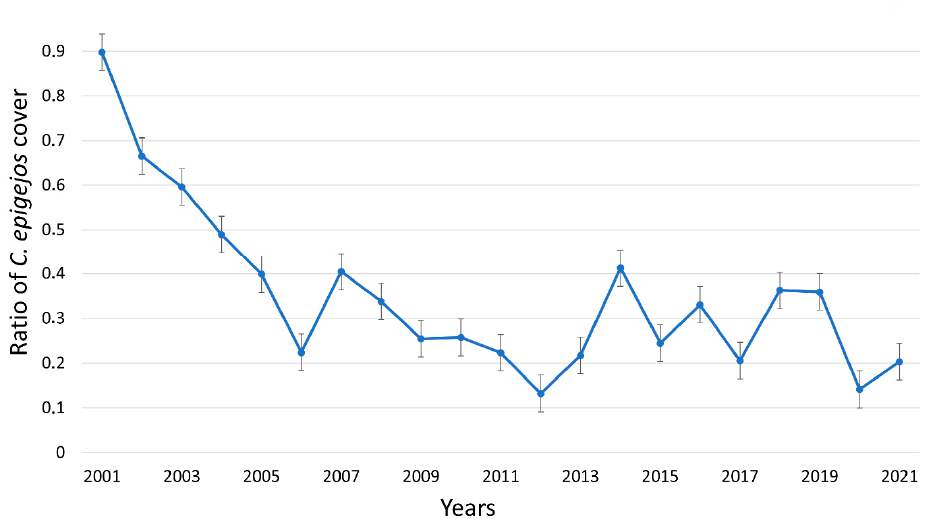
Figure 4. Ratio of C. epigejos cover between mown and control plots with standard errors over the study period.